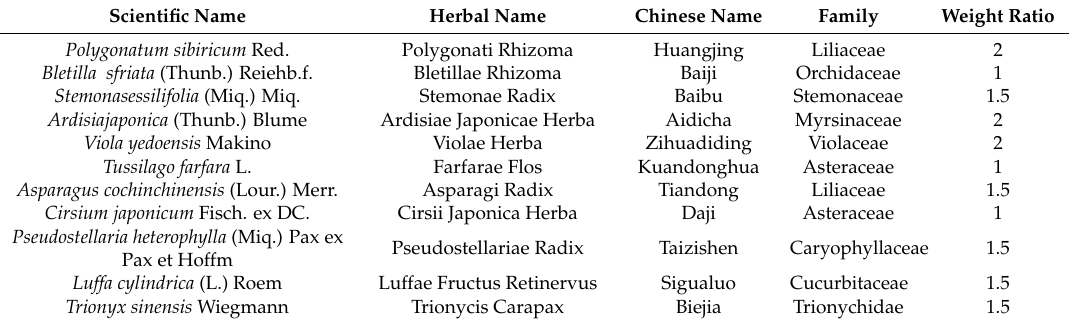
Table 1. The information of each components in Yifei Tongluo